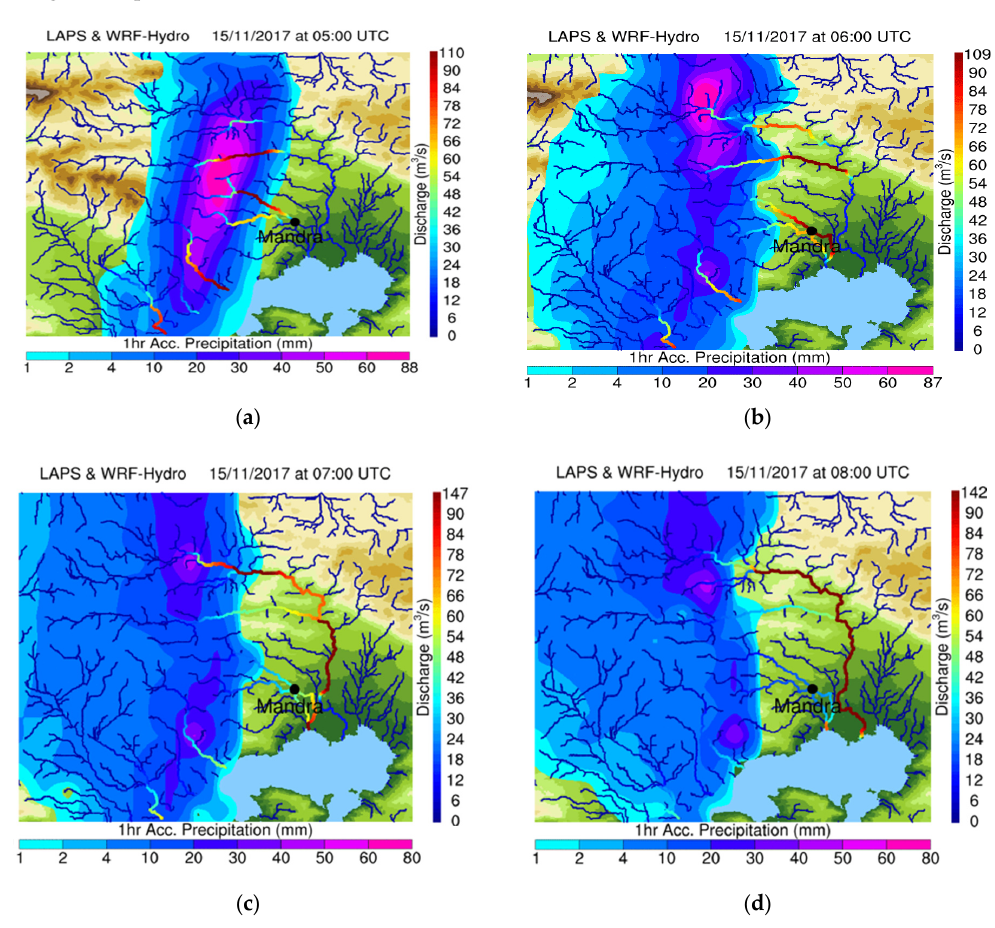
Figure 7. One hour accumulated precipitation superimposed with the simulated discharges forced by the LAPS nowcasts. WRF-Hydro simulation starting on 15 November at 04:00 UTC and going up to 08:00 UTC every hour ( a – d ), forced by the LAPS nowcasts from 05:00 to 08:00 UTC. Streams with order 4 or higher are